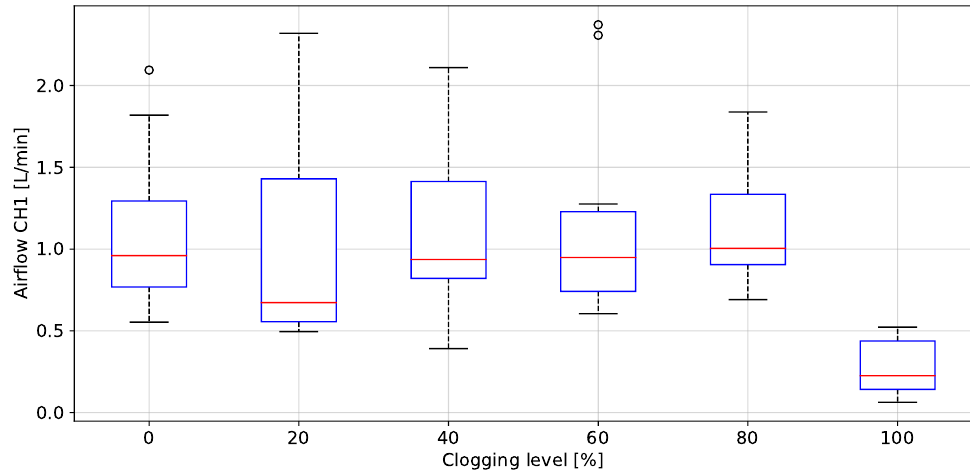
Figure 23. Peak to peak values of airflow (transducer left) as a function of the clogging level.